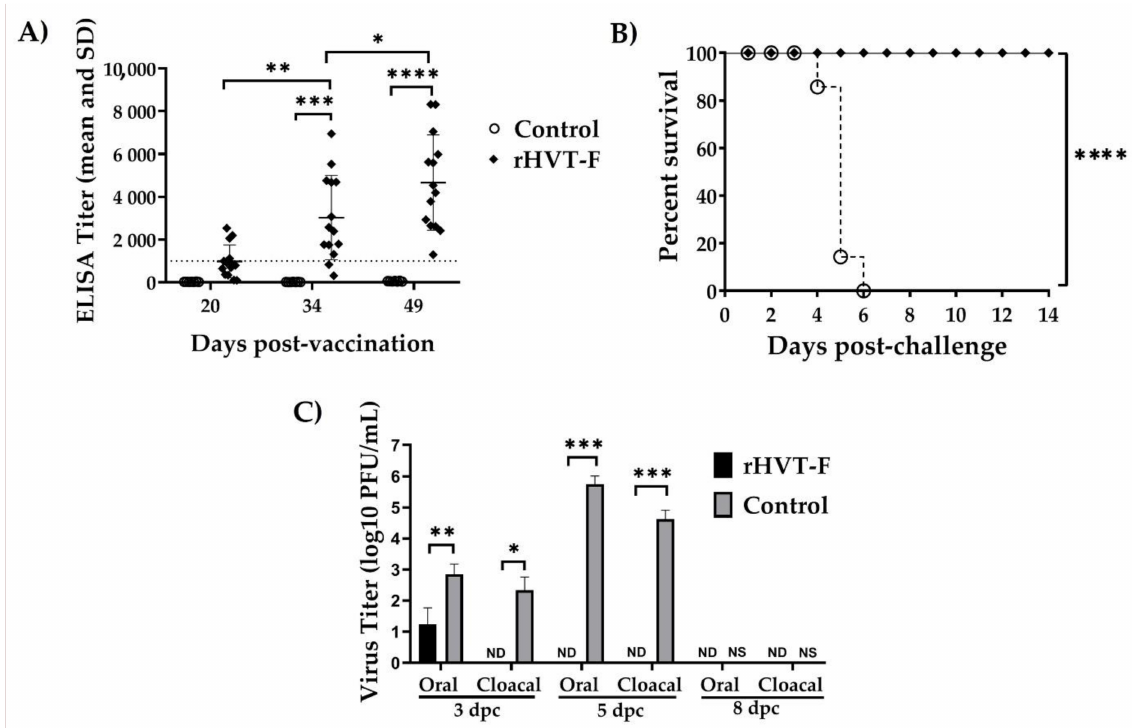
Figure 5. Humoral immune response and protection conferred by rHVT-F vaccine against genotype XII NDV challenge. Two groups of specific pathogen-free (SPF) chickens: Group #1 = vaccinated with rHVT-F virus ( n = 14) and group #2 = non-vaccinated control to challenge wtHVT ( n = 7) were immunized once at 1-day-old, and the challenge performed 49 days post-vaccination (dpv) with 10 5 median lethal doses (LD 50 )/chicken via the oculo-nasal route. ( A ) NDV-specific IgY antibodies in vaccinated chickens at 20, 34, and 49 dpv. Serum samples that were negative for enzyme-linked immunosorbent assay (ELISA) titer are shown below the limit of detection (Cutoff = 993). SD: Standard Deviation. ( B ) The survival rate of vaccinated chickens showed no mortality in 14 days following the challenge (dpc). ( C ) Titers of challenge virus shedding, from oral and cloacal swabs from chickens, after the challenge is quantitated by a plaque assay. ND = not detected; NS =